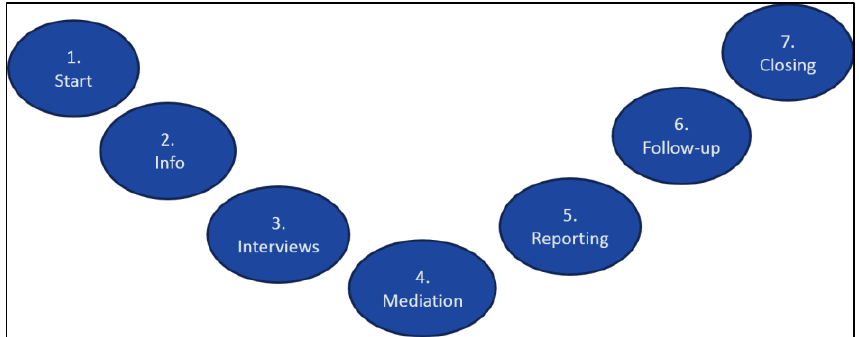
Figure 1. The seven phases of the restorative conflict mediation process (Modified from Domenici & Littlejohn, 2001